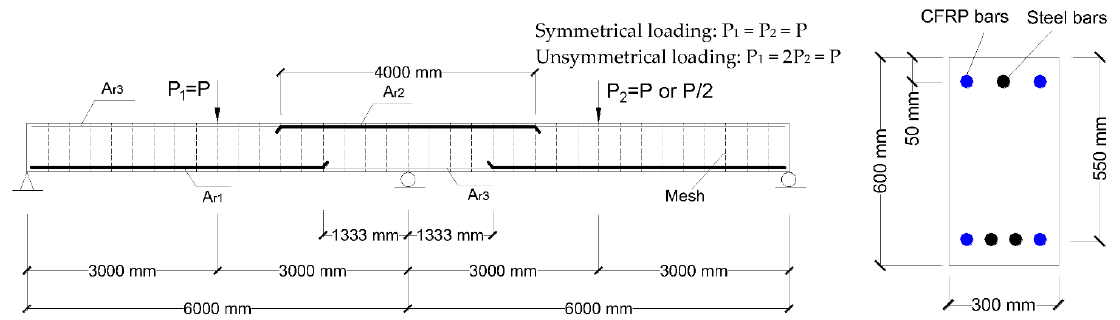
Figure 2. RC continuous beams with hybrid CFRP-steel bars and the finite element mesh.